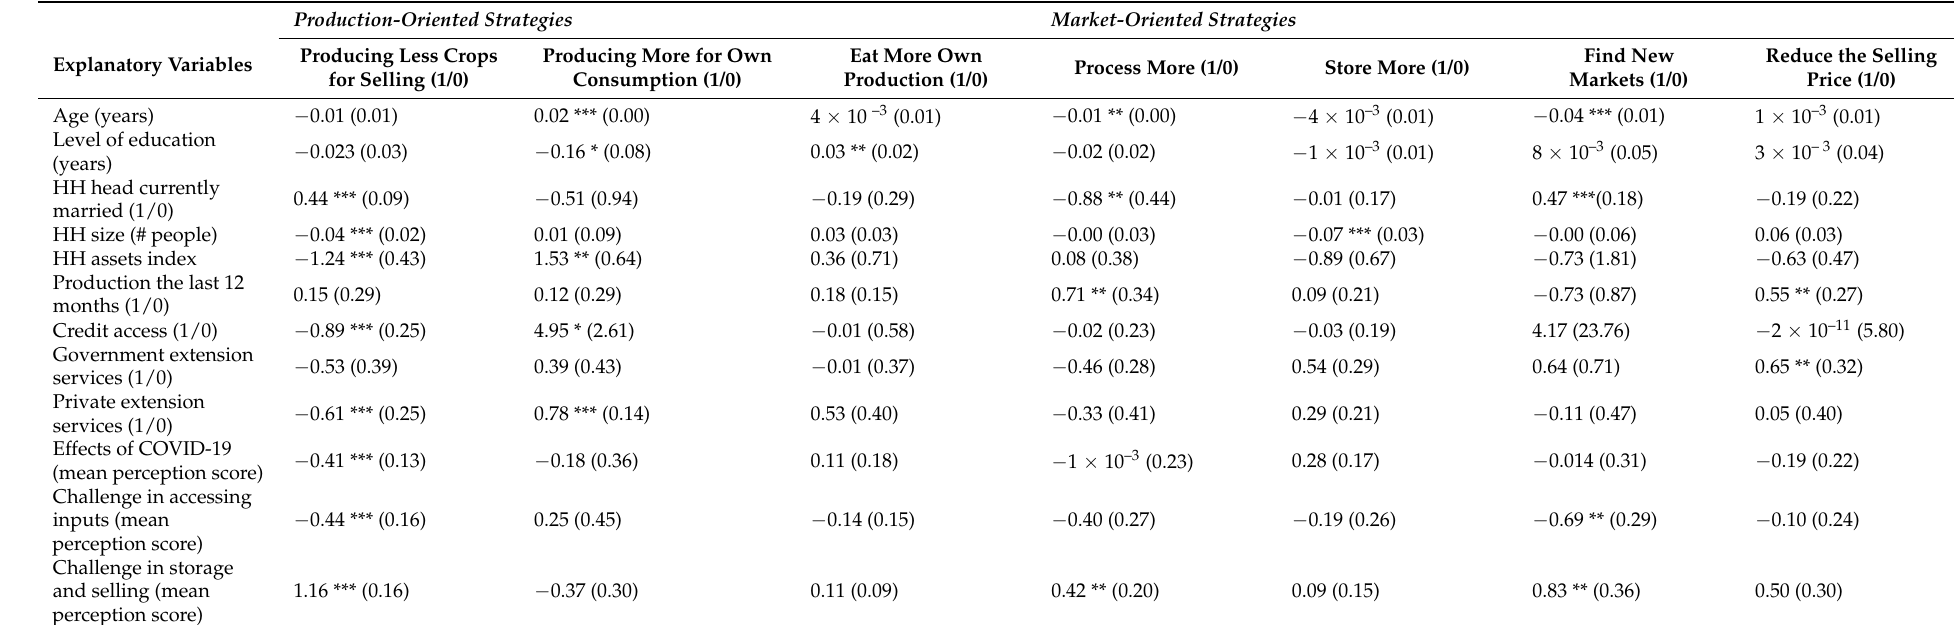
Table 8. Results of the multivariate probit